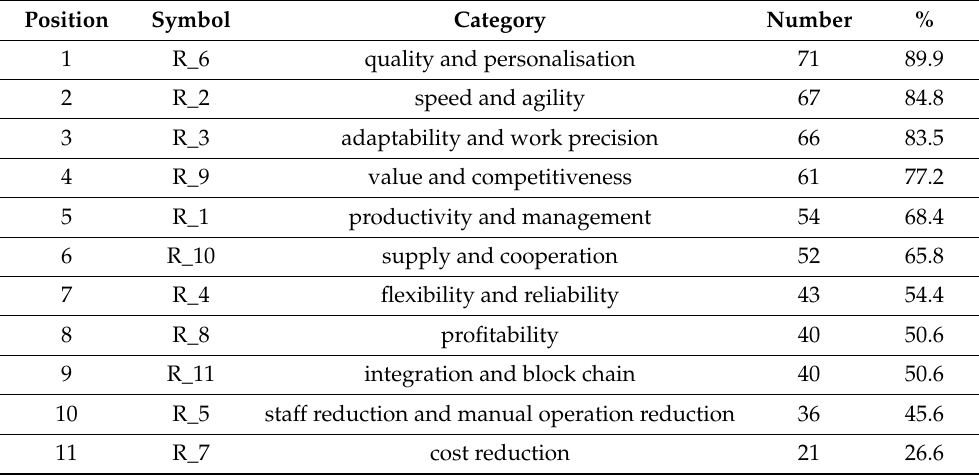
Table 3. Influence of the SM projects on business operation according to categories with the highest ratings.